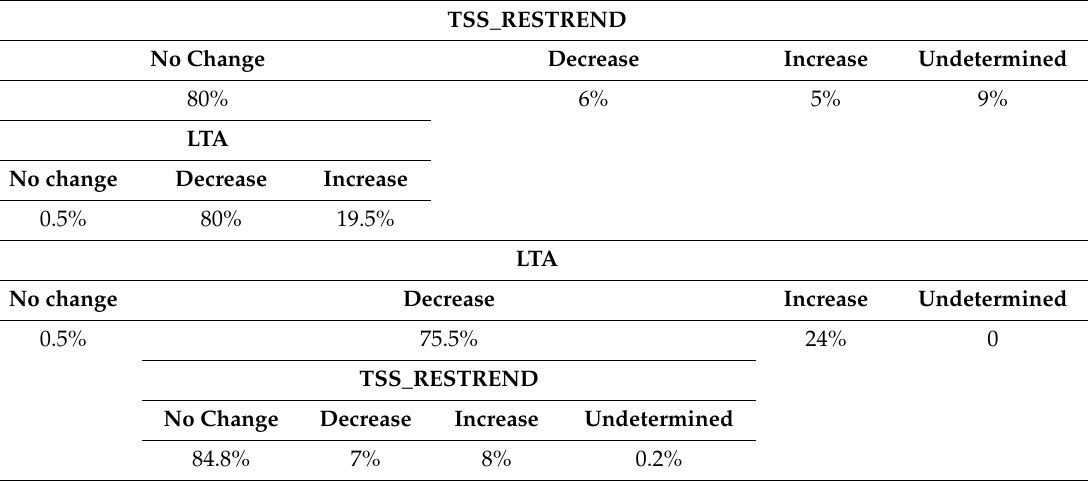
Table 2. NDVI change results between TSS-RESTREND and LTA in